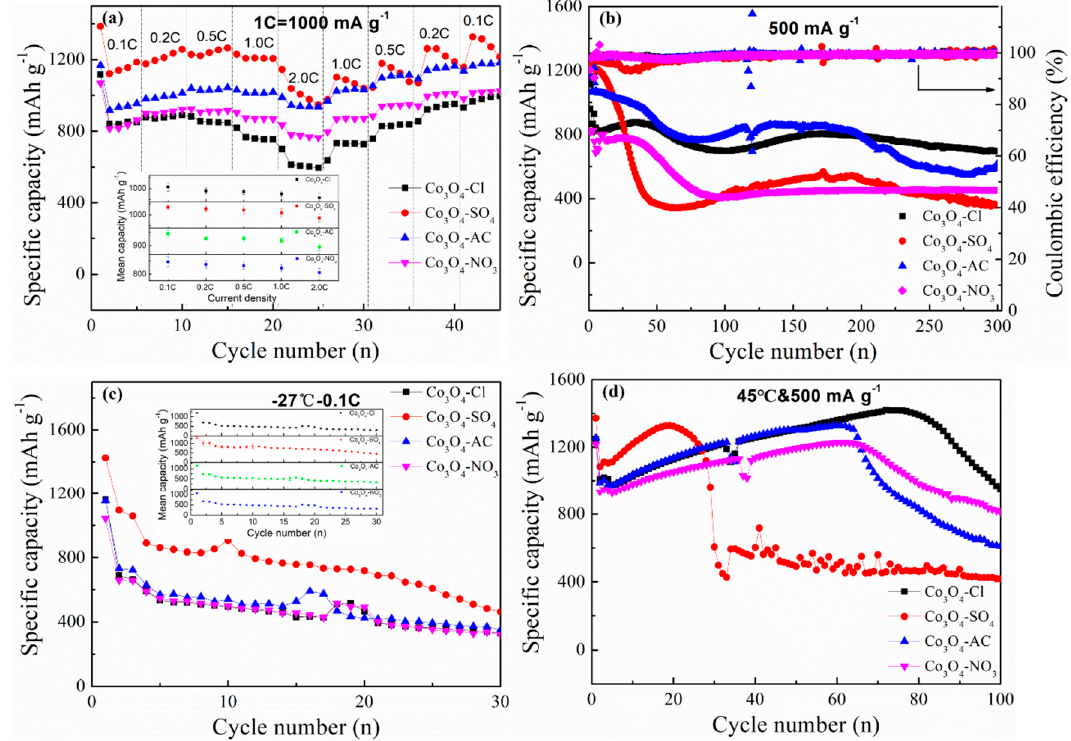
Figure 8. ( a ) Rate performances of the as-prepared Co 3 O 4 -Cl, Co 3 O 4 -SO 4 , Co 3 O 4 -AC, and Co 3 O 4 -NO 3 at various current densities from 0.1 C to 2.0 C. ( b ) Cycle stability of Co 3 O 4 -Cl, Co 3 O 4 -SO 4 , Co 3 O 4 -AC, and Co 3 O 4 -NO 3 materials in the cells standing for 60 days and cycled at 500 mA·g − 1 . ( c,d ) Cycle performance of the cells at low temperature ( − 27 °C) and high temperature (45 °C). The insert pictures represent the error bar with standard deviation. The specific capacity corresponds to the discharge process, i.e., Co 3 O 4 reacts with Li + to form Co and Li 2 O.